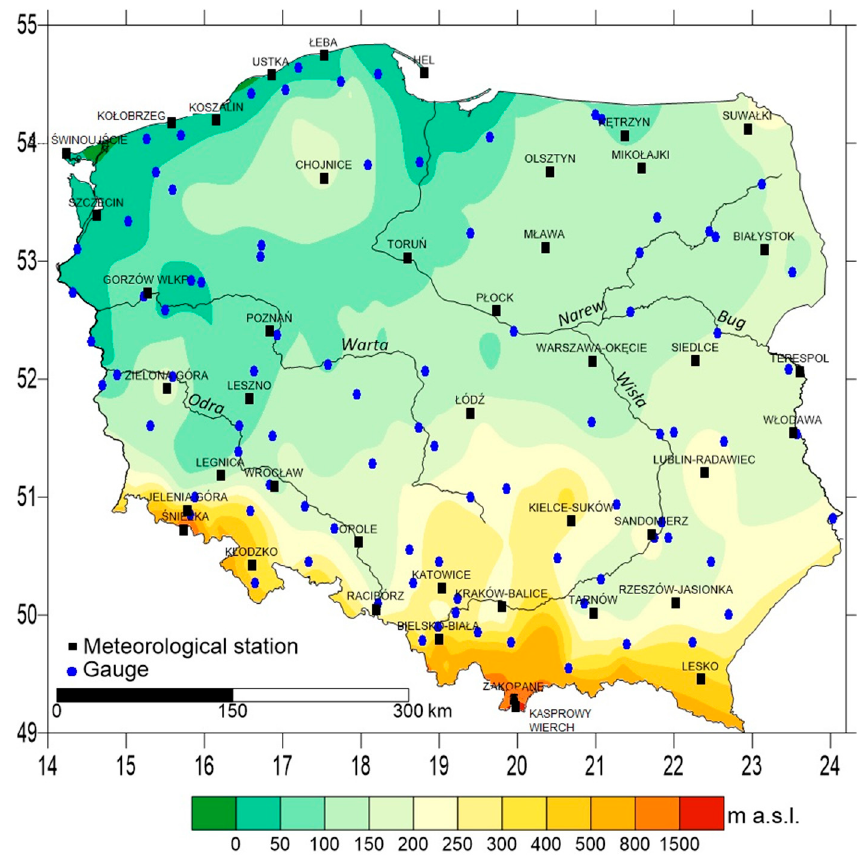
Figure 1. Location of the water gauges and meteorological stations.